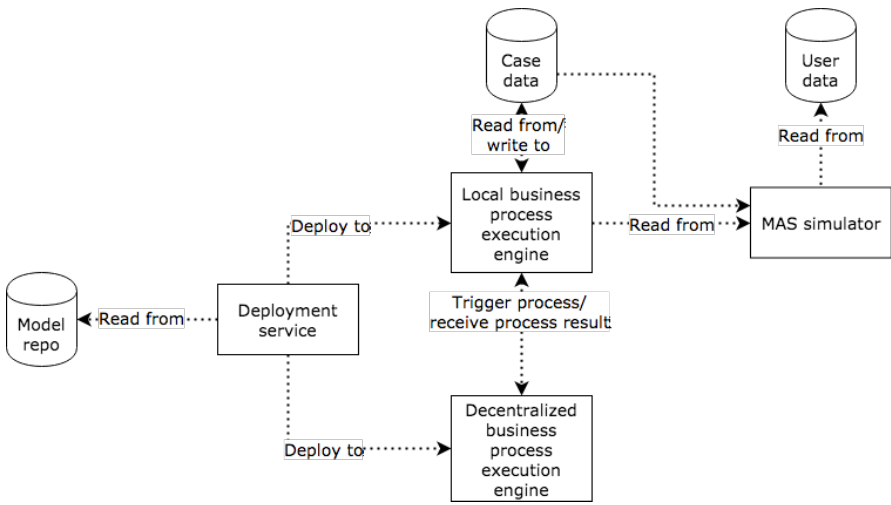
Figure 2. Architecture proposal: Graphical